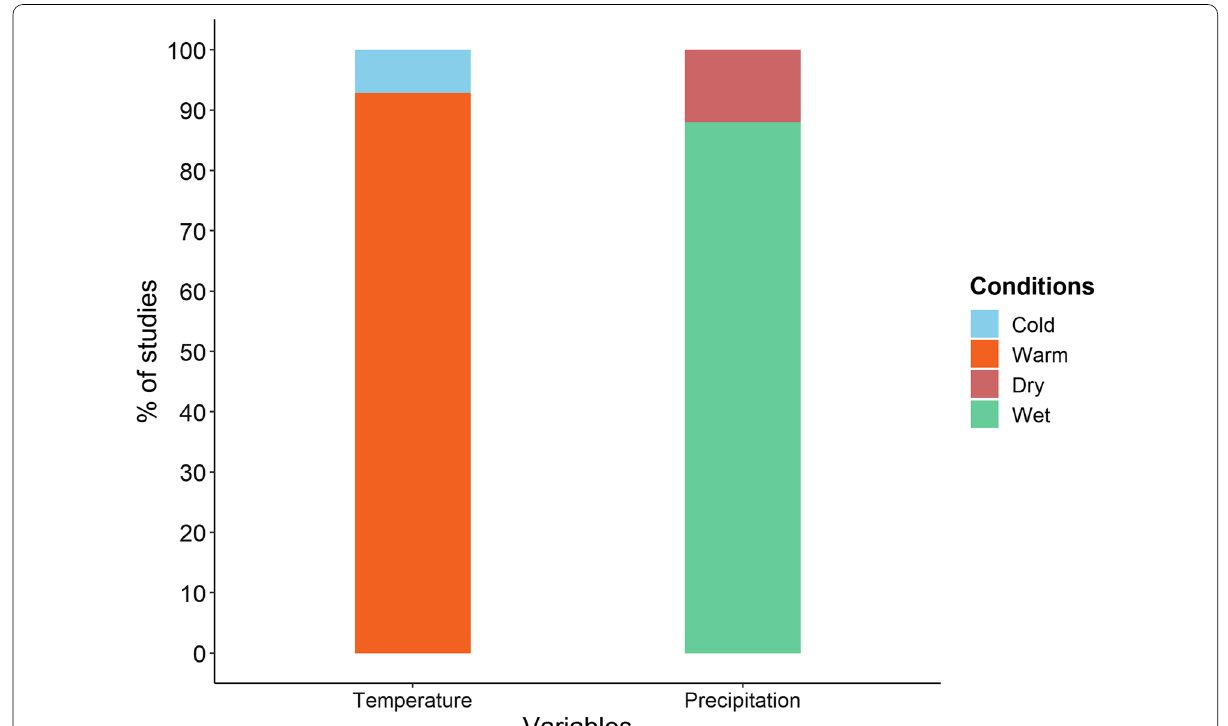
Fig. 5 Relationship of temperature and precipitation during the Bølling–Allerød interstadial. The number of studies used for the warm/cold or wet/ dry conditions can be found in Table